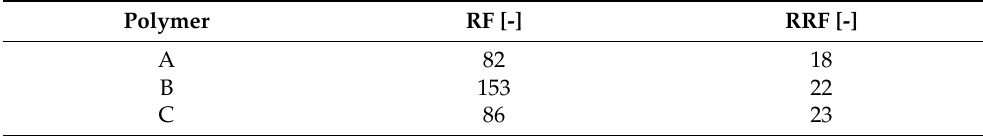
Figure 8. Comparison of the single-phase core flood data obtained for injection at a Darcy velocity of 5 m/d in Berea cores with ~485 mD. Table 4. Calculated RF and RRF values of single-phase core flood experiments.